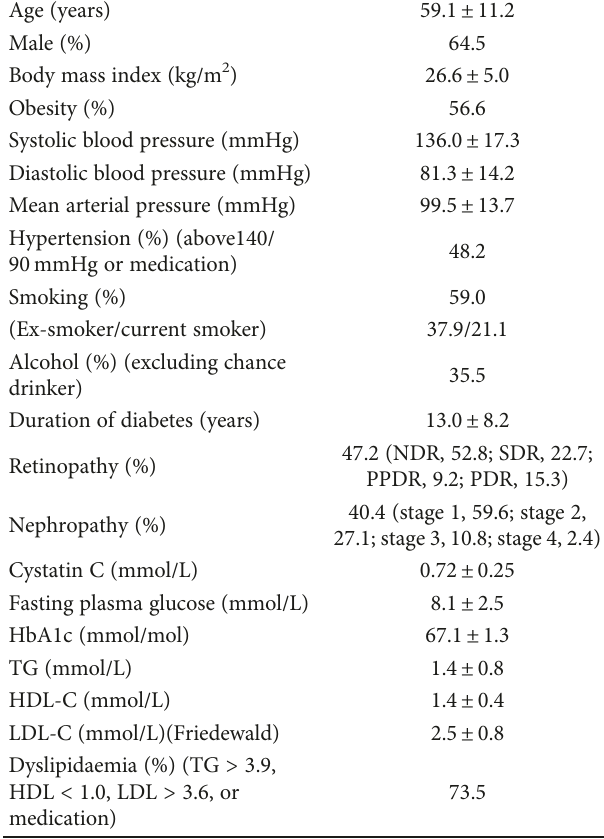
Table 1: Clinical pro fi le of the patients ( n = 166